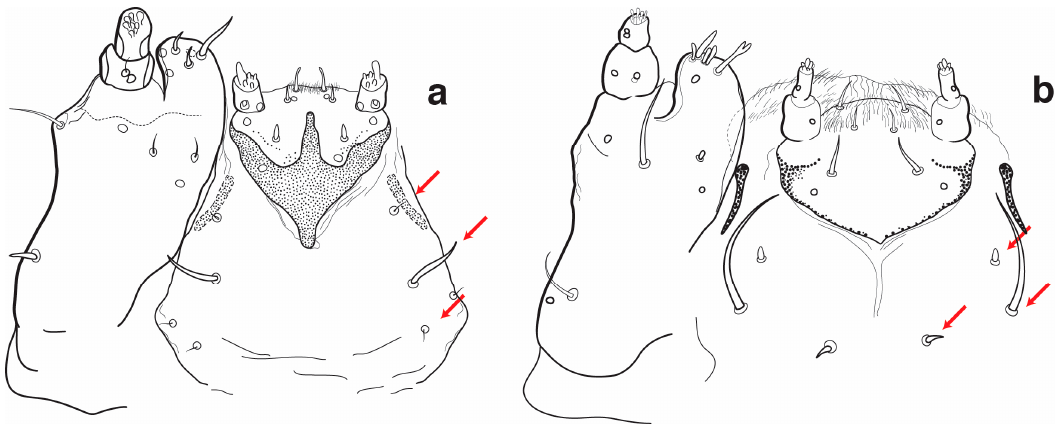
Figure 53. Labium, larva: ( a ) Stenommatus ; and ( b ) Polytus .